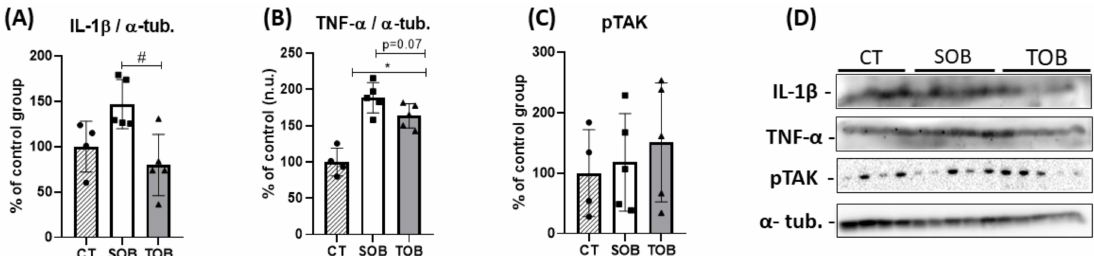
Figure 3. Inflammatory profile. ( A ) Quantification of IL-1 β . ( B ) TNF- α content. ( C ) Phosphorylation of transforming growth factor β -activated kinase 1 (pTAK1). ( D ) Band of proteins measured by immunoblotting in retinal tissue. All proteins were relativized by α -tubulin. The bars represent the mean ± SD of the control (CT), sedentary obese (SOB), and trained obese groups (TOB) ( n = 4–5 per group). * p < 0.05 vs. CT; # p < 0.05 vs. TOB. For the results presented in bar graphs,